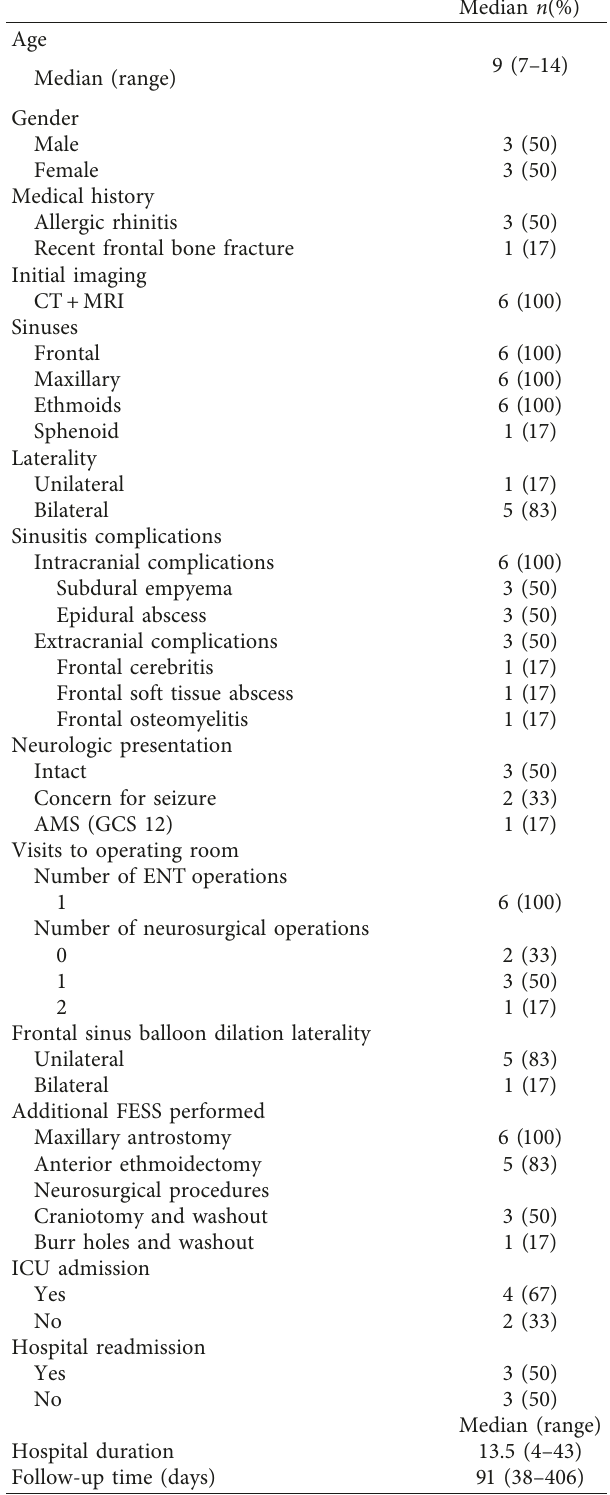
Table 1: Demographic, clinical, and management characteristics of complicated pediatric ARS patients ( n �